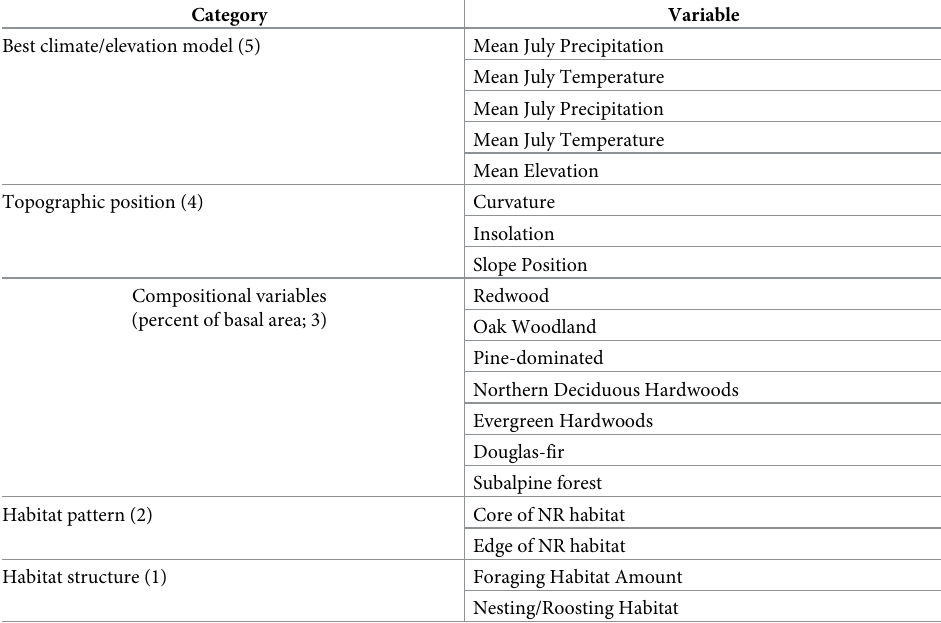
Table 3. Categories of candidate variables (and order of entry), variable names of variables used in the relative habitat suitability modeling